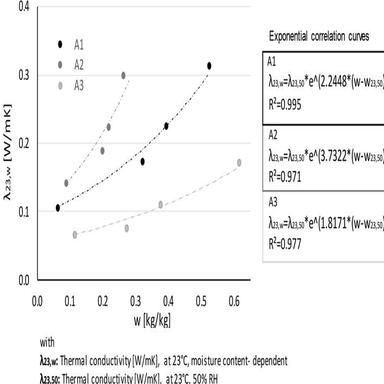
Thermal conductivity of thermal mortars at different water contents and 23 ◦C. On the left, the graphic presents the measured data (grey and black points) and the exponential regression curves correlating thermal conductivity and water content for each thermal mortar (dashed lines). On the right, the expression and coefficient of determination of the curves are reported.